Question: Author a descriptive caption for the visualization shown.
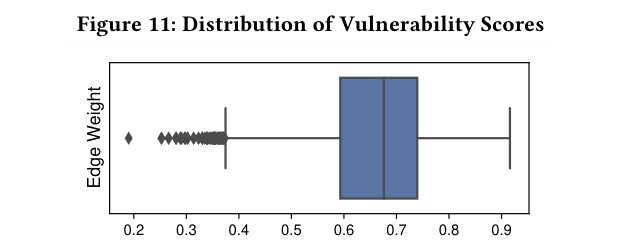
Answer: Distribution of Attack Graph Edge Weights